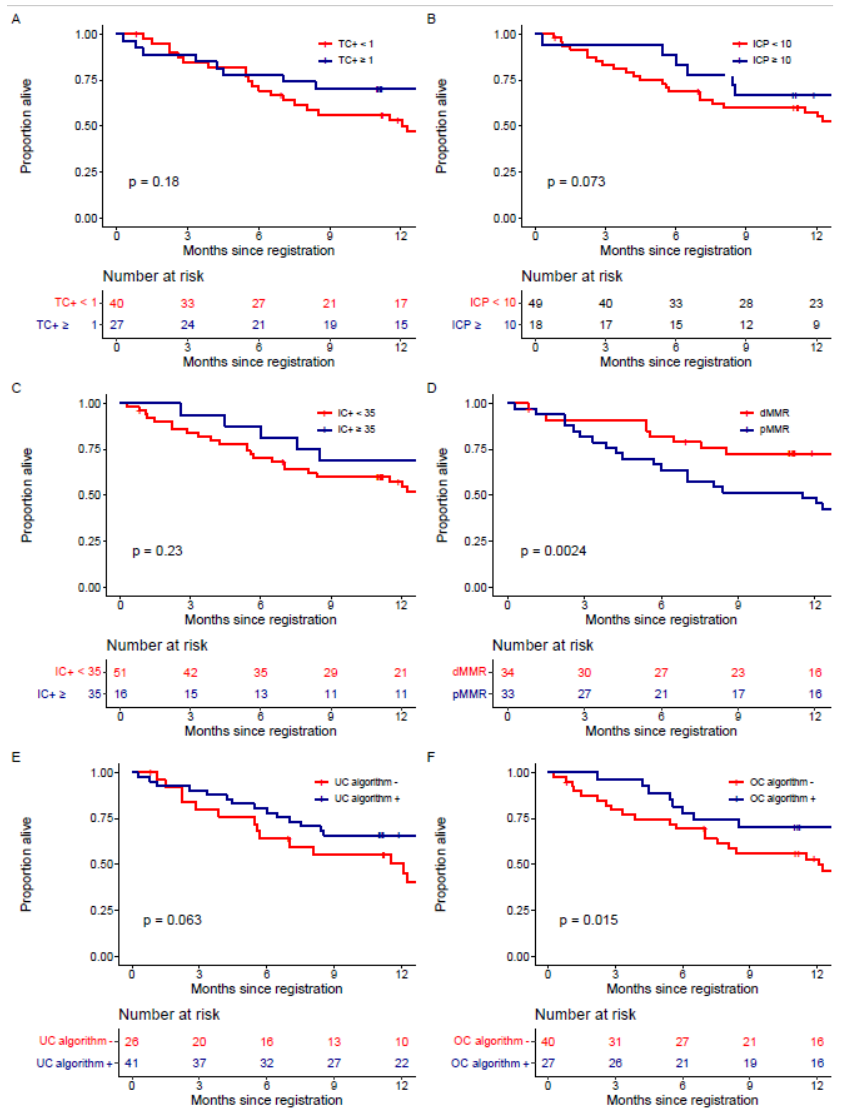
Figure 4. Kaplan – Meier curves for overall survival for ( A ) TC+, ( B ) ICP, ( C ) IC+, ( D ) MMR, ( E ) the urothelial cancer (UC) algorithm and ( F ) the optimal cutpoint (OC) algorithm.